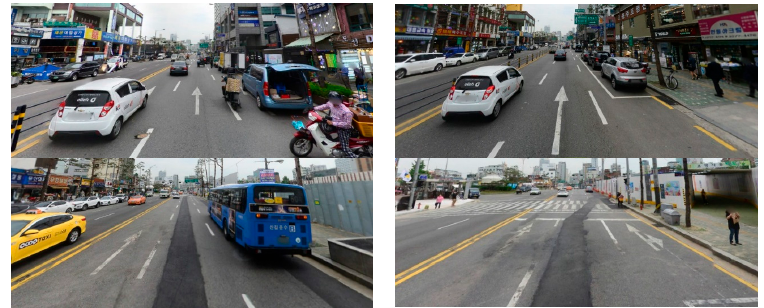
Figure 7. Example images from Naver street view dataset.